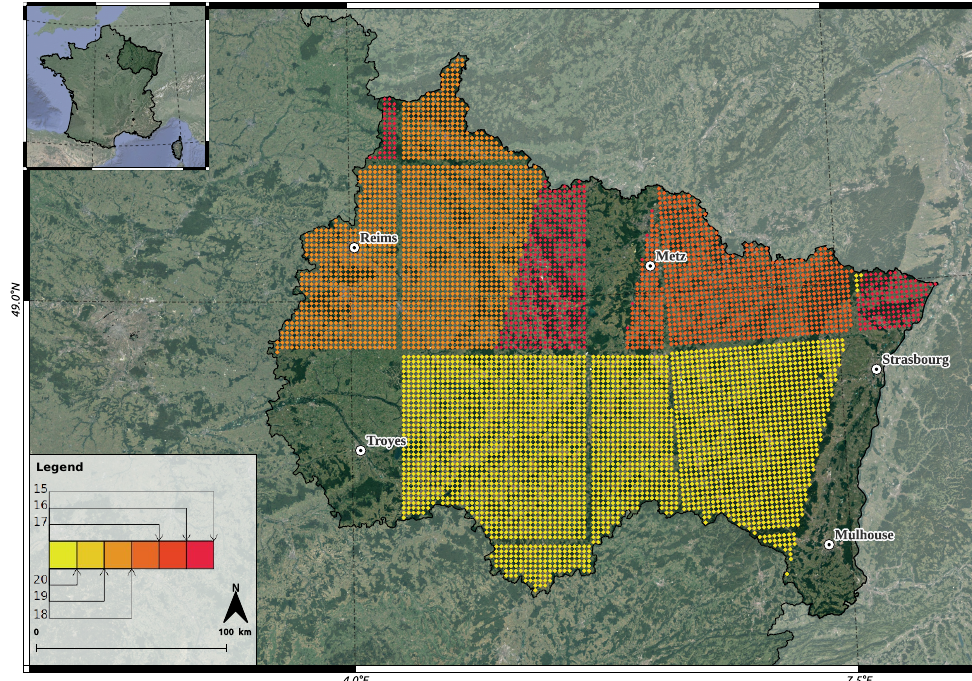
Figure 3. Distribution of patches over the study area according to the number of days between two consecutive dates for the months of July, August, September and November (2020). Table 1. Number of patches depending on the days gap for two consecutive months. Days Gap for Two Consecutive